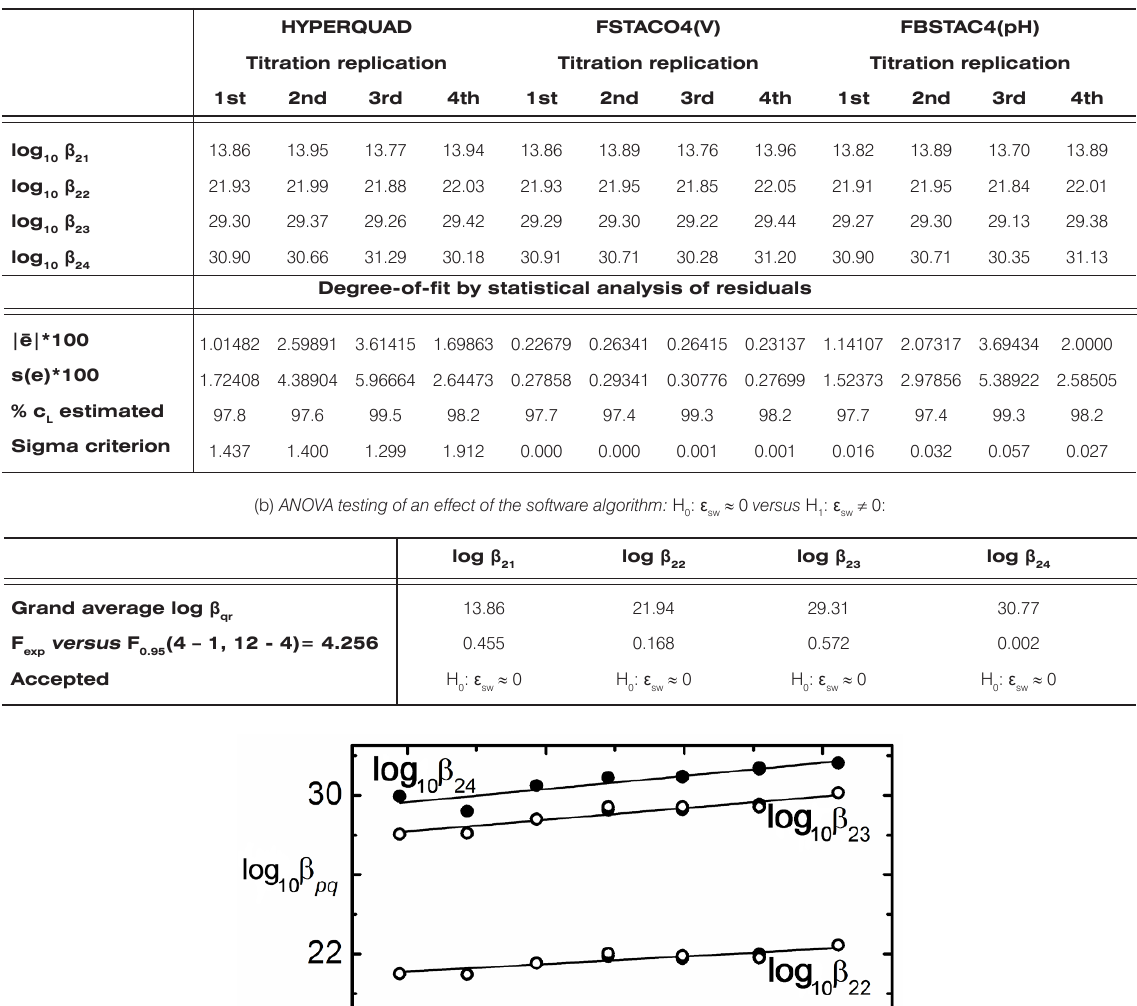
Table 3. (a) Influence of software algorithm used on the reliability of formation constant of dimers in the system H + -vildagliptin by regression analysis of potentiometric titration curve ( cf ., Fig. 2) using the program HYPERQUAD, FSTACO4(V) and FBSTAC4(pH). (b) Grand averages of formation constants of dimers and ANOVA testing of significance of influence of software algorithms with titration replication. Experimental conditions: H